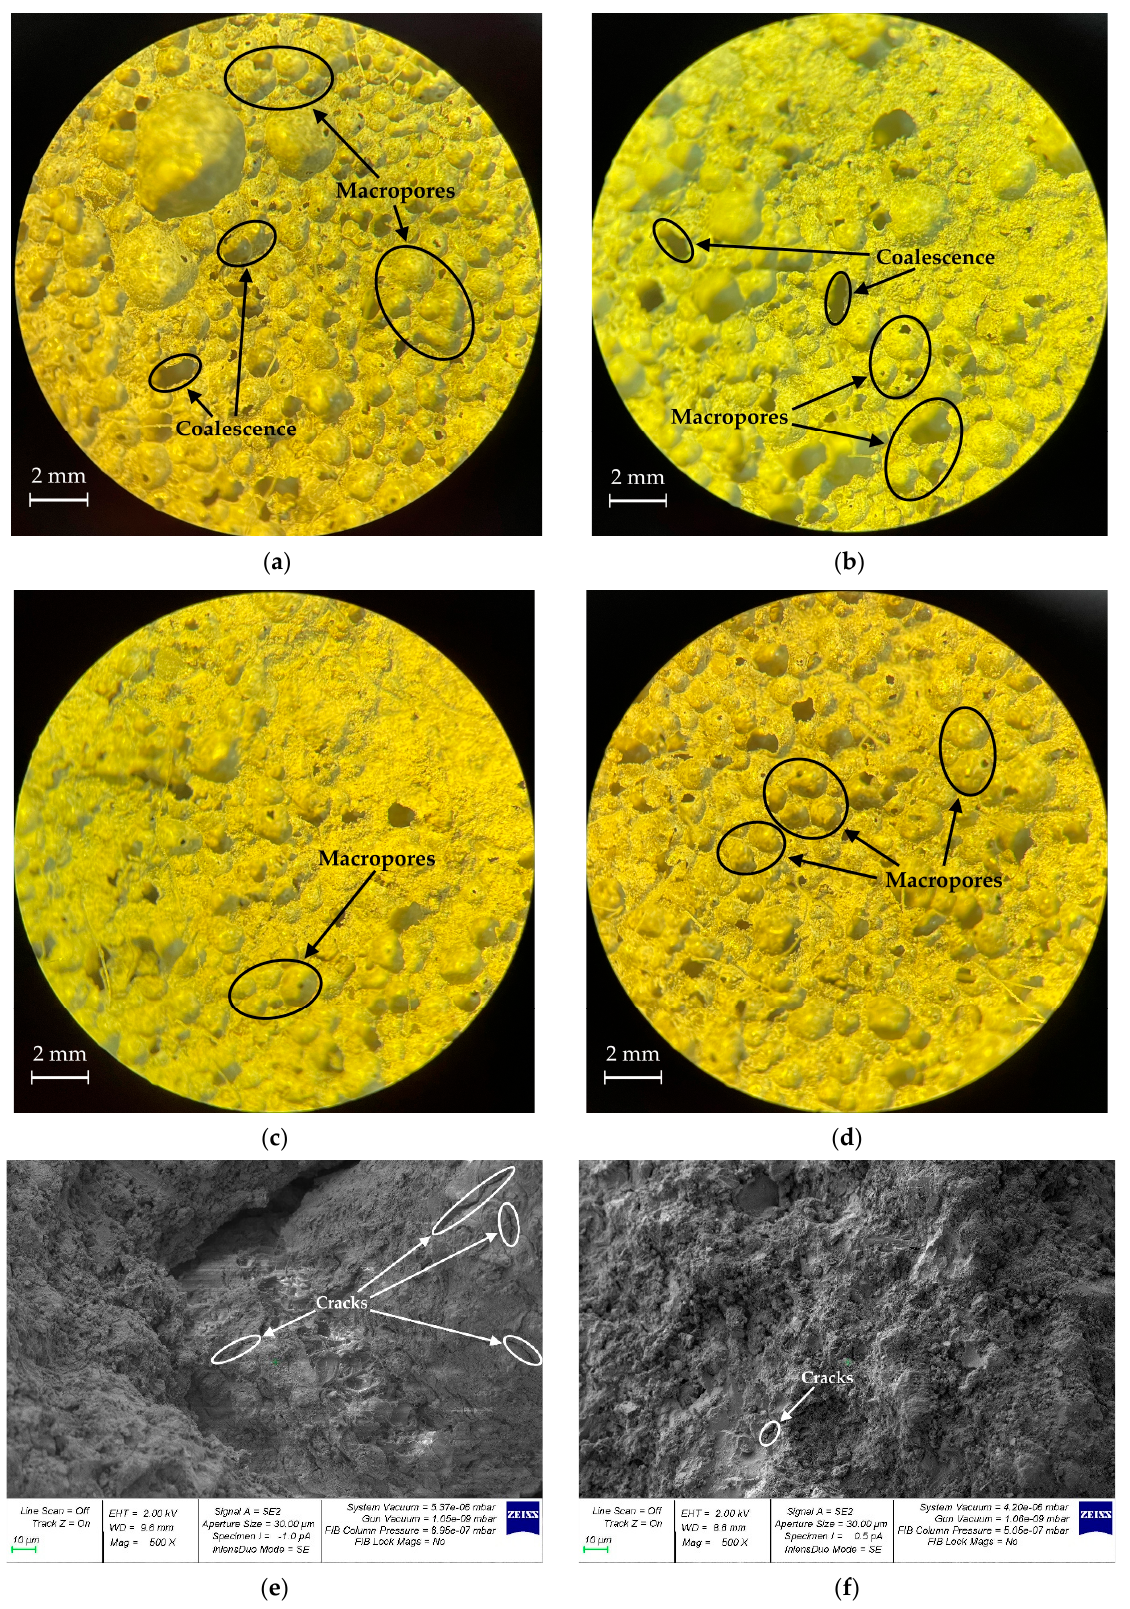
Figure 15. Photographs of the structure of samples: ( a ) aerated concrete GGBS + CF; ( b ) aerated concrete GGBS + SF; ( c ) aerated concrete FA + CF; ( d ) aerated concrete FA + SF; ( e ) hardened cement paste CF; and ( f ) hardened cement paste SF.